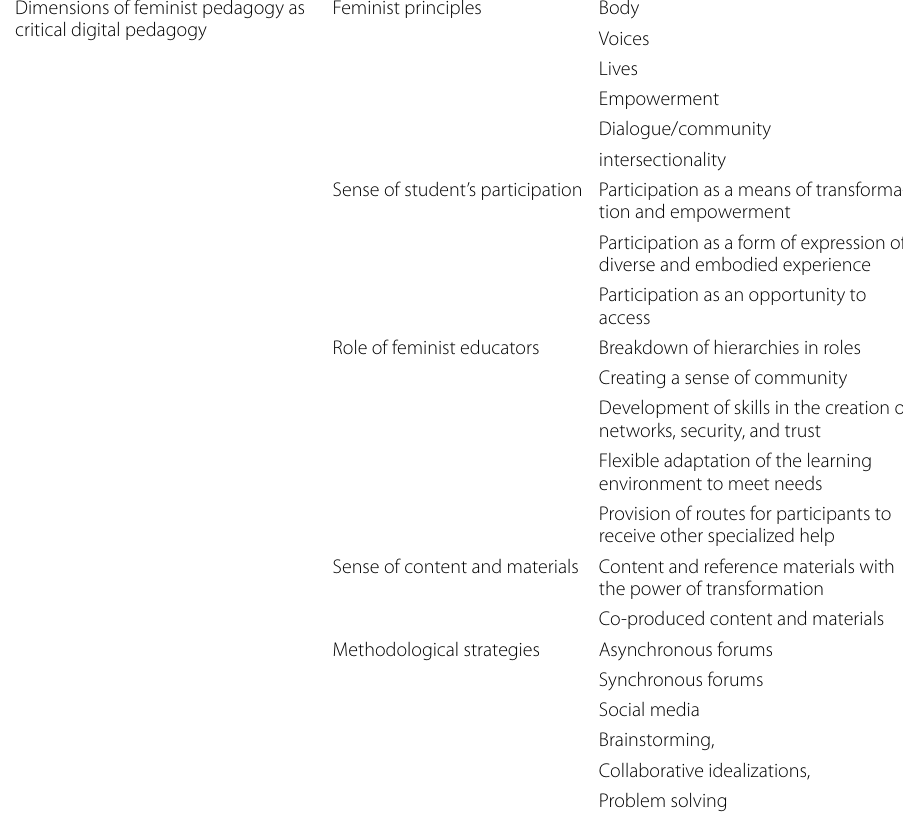
Table 2 Category system Dimensions of feminist pedagogy as critical digital